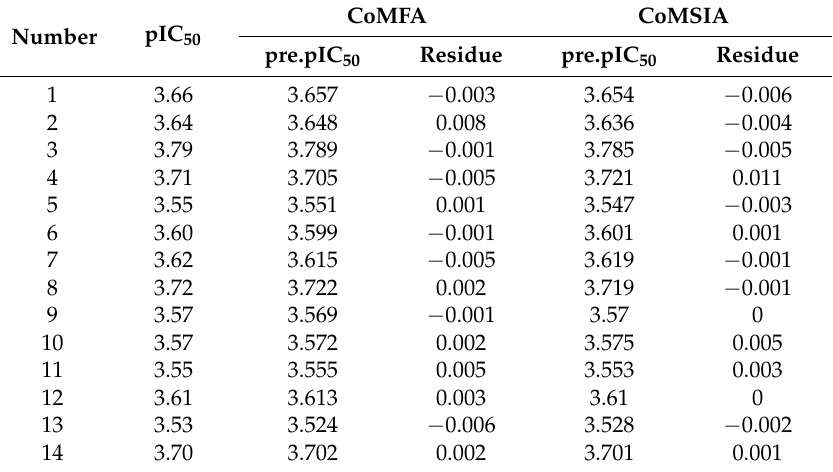
Table 3. Xanthones and their observed and predicted (pre.) XO inhibition